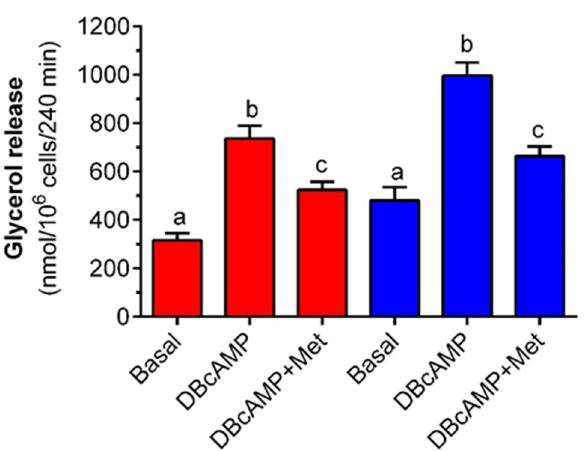
Figure 4. The effects of metformin on DB-cAMP-induced glycerol release in isolated rat adipocytes in the presence of low and high concentrations of glucose. Adipocytes were preincubated for 3 h with or without 1 mM metformin in the buffer containing 3 mM glucose (red bars) or 12 mM glucose (blue bars). Then, 0.5 mM DB-cAMP was added to all cells (except for basal) and incubations were performed for an additional 1 h. After the end of the incubations, adipocytes were removed and the glycerol content in the buffer was determined. DB-cAMP—dibutyryl-cAMP, Met—metformin. The obtained results represent the mean ± SEM from 3 independent experiments in 5 repetitions ( n = 15). Values marked by different letters within each experimental group differ significantly at p < 0.05.